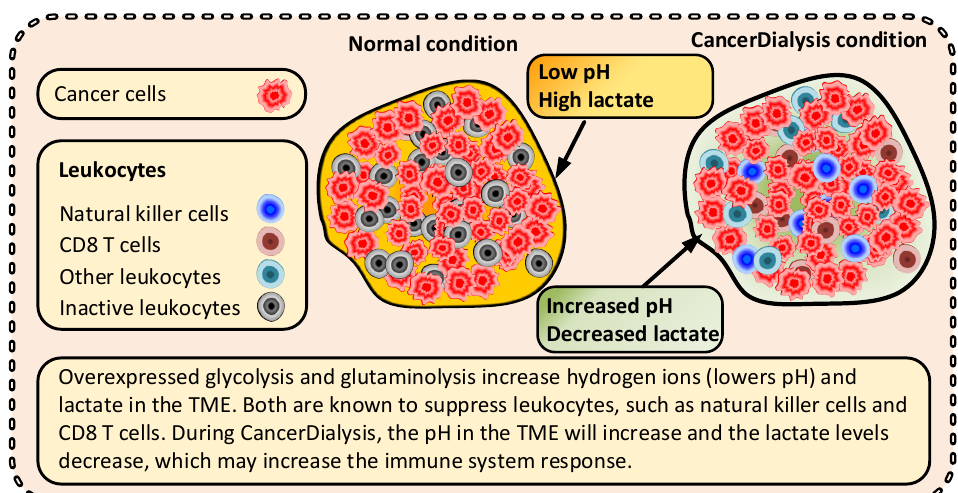
Figure 8. It is well known that the TME is a harsh environment for the infiltrating leukocytes. CD8 T cells and natural killer cells are important immune cells for targeting cancer cells and are known to be inactive at low pH and high lactate levels [15,37,70,104–108].